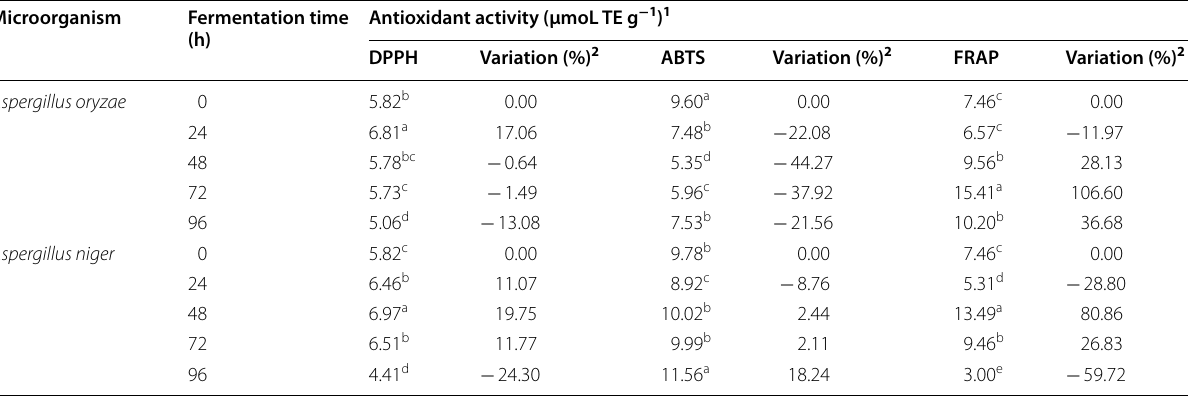
1 Results are expressed as mean ( n 3) and those with different letters are significantly different in the same column ( p = 2 The variation (%) was calculated as a function of the values of µmol TE g − 1 obtained for the fermented samples in relation to their respective 0 (nonfermented sample)